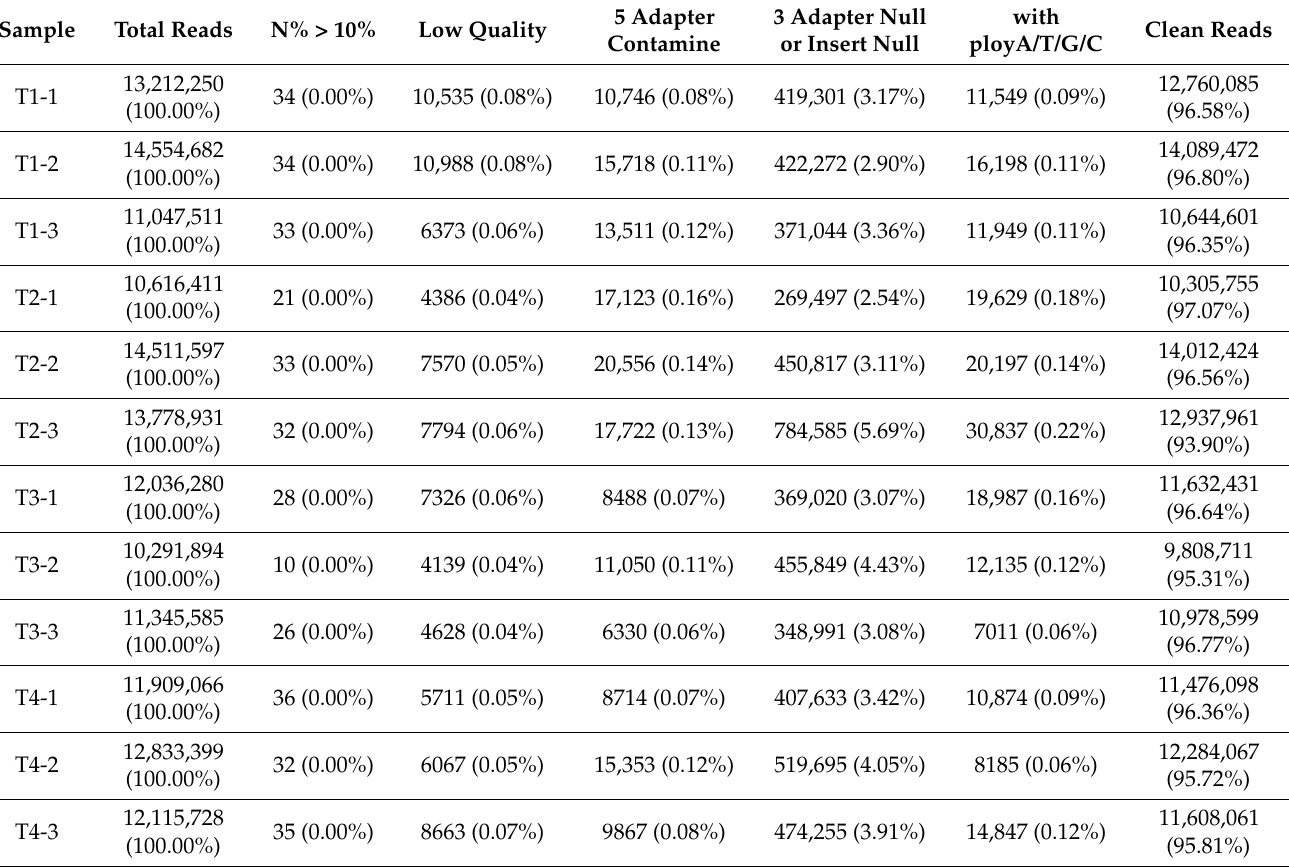
Table 1. Summary of filtered data produced by small RNA sequencing.